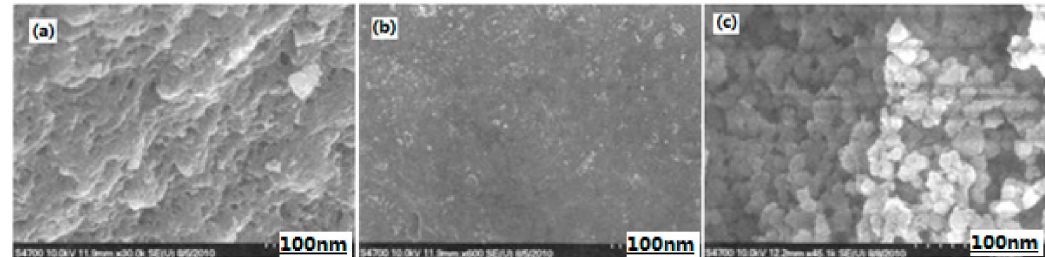
Figure 13. SEM photos of di ff erent particles. ( a ) Fe 2 O 3 gas gel; ( b ) lowresolution microscopic of Al / RDX / Fe 2 O 3 composite; and ( c ) high-resolution microscopic of Al / RDX / Fe 2 O 3 composite. Reproduced from [51], with permission from Han Neng Cai Liao, 2011.